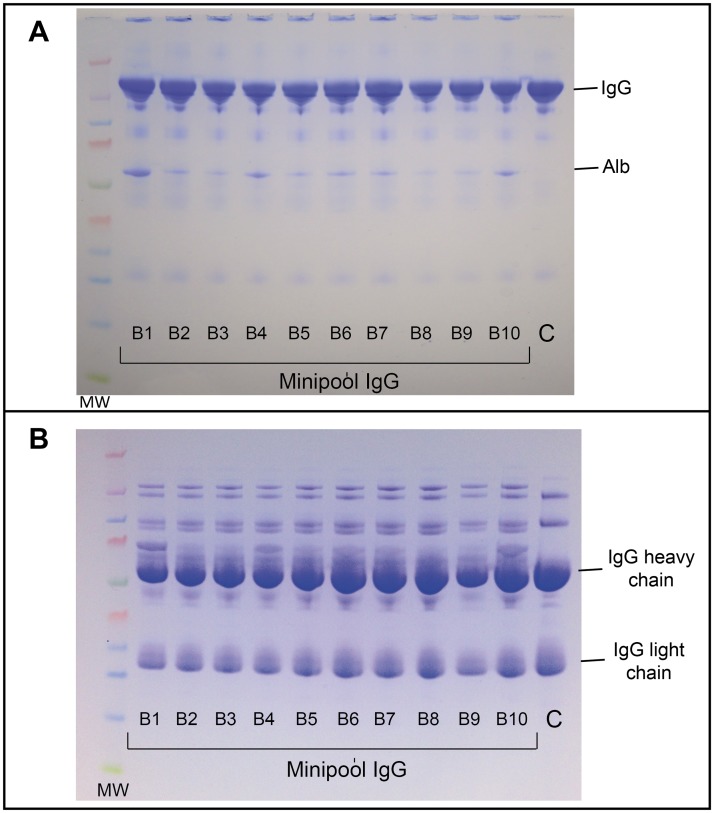
Sodium dodecyl sulfate-polyacrylamide gel electrophoresis.Patterns of 10 consecutive batches of minipool IgG-enriched plasma fractions (Minipool IgG batches B1 to B10) and control IgG (C) under non-reducing (A) or reducing (B) conditions. Control: control IgG; IgG: immunoglobulin G; Alb: albumin. MW: molecular weight markers (kDa).